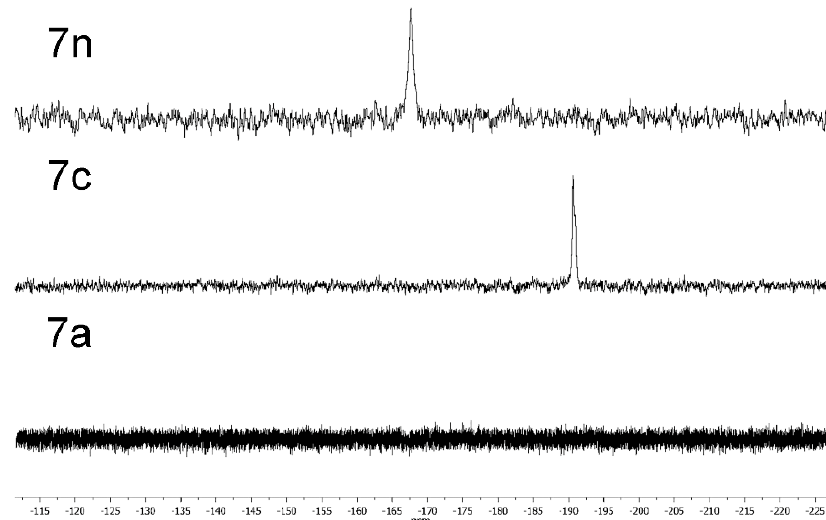
Figure 4. 31 P{1H} NMR spectra of different forms of compound 7 in CHCl 3 .